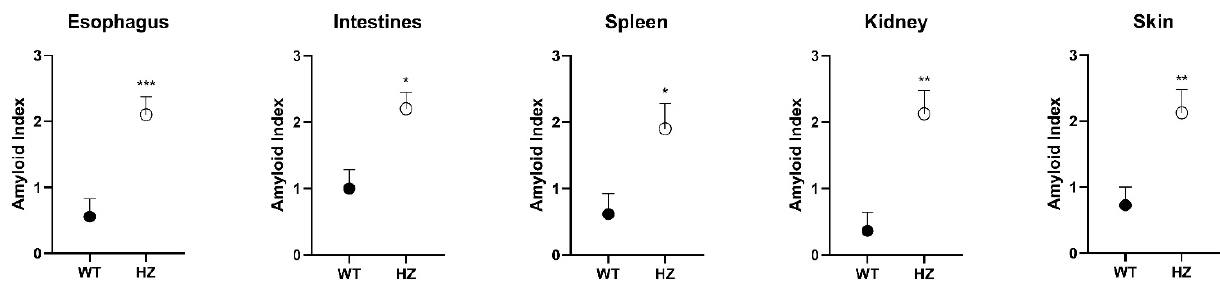
Figure 2. Overall amyloid index in young and aging WT and PACAP HZ mice in the most severely affected organs. Scores are represented as mean + SEM, * p < 0.05; ** p < 0.01, *** p < 0.001 compared to WT mice.